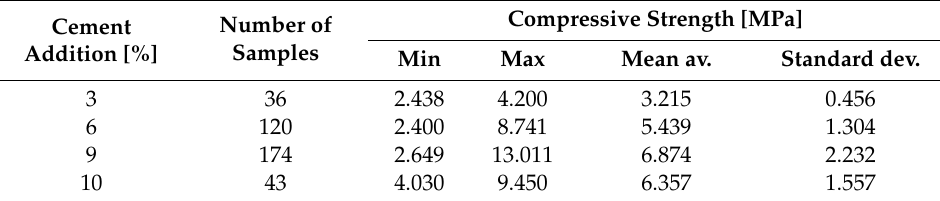
Table 6. Results of compressive test of 373 samples of